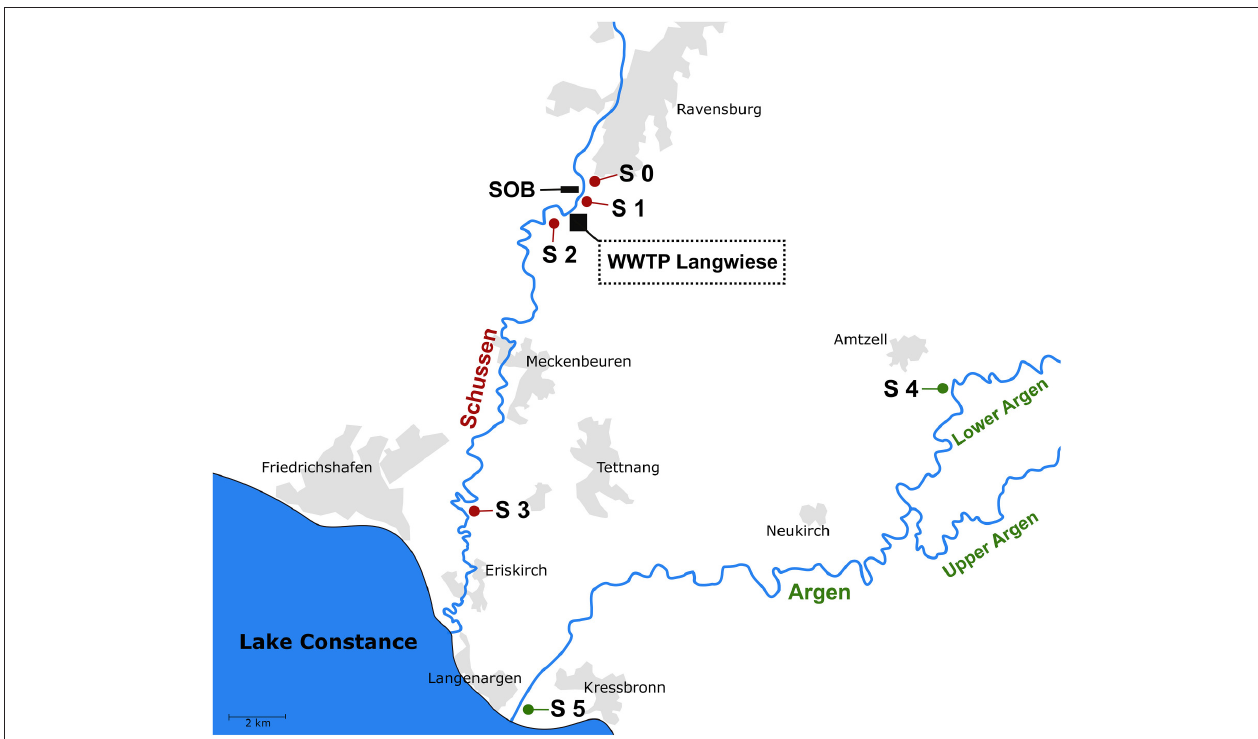
FIGURE 1 | Sampling sites at the Schussen and the Argen river, two tributaries to Lake Constance. Gammarids were collected at sampling sites S 0, S 3, and S 5. Macrozoobenthos was sampled at sampling sites S 0, S 1, S 2, S 3, and S 4. WWTP, wastewater treatment plant Langwiese (AZV Mariatal); SOB, stormwater overflow basin Mariatal. For exact coordinates of sampling sites see chapter 2.1. The map is based on OpenStreetMap. Map data: © OpenStreetMap contributors, license: